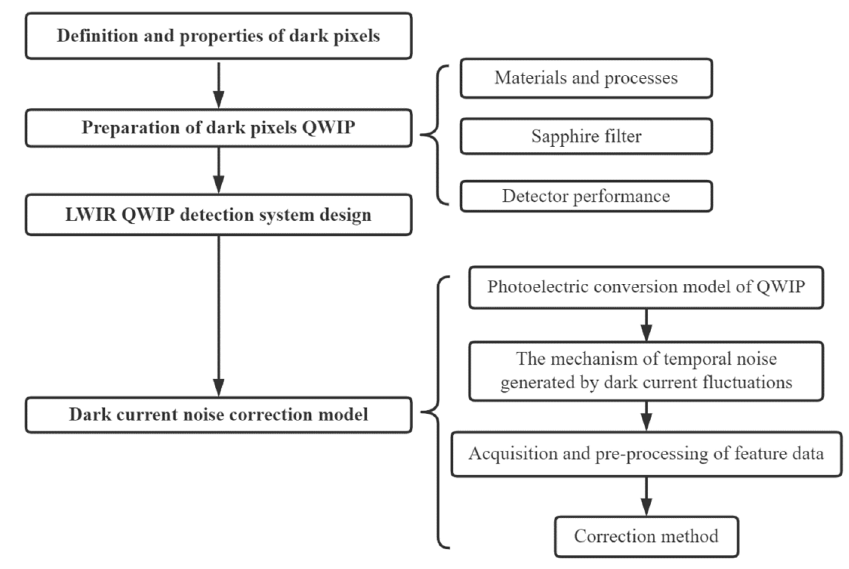
Figure 1. Schematic diagram of the dark current noise correction model.